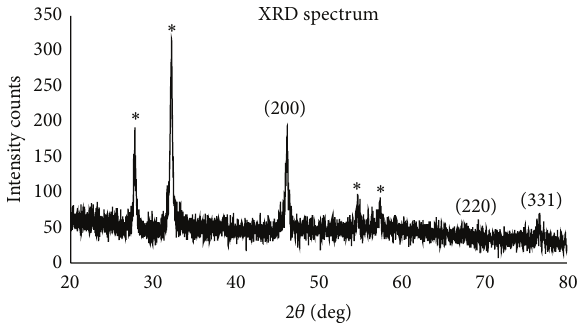
Figure 3: XRD pattern of extracellular synthesized silver nanoparticles using Planomicrobium sp.